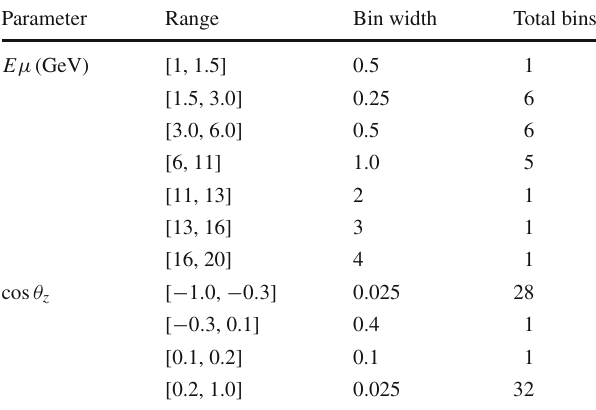
Table 4 The binning scheme adopted for the reconstructed parameters E μ and cos θ z for muons produced due to both up-coming and down- going neutrinos, for the χ 2 estimations with muons only Parameter